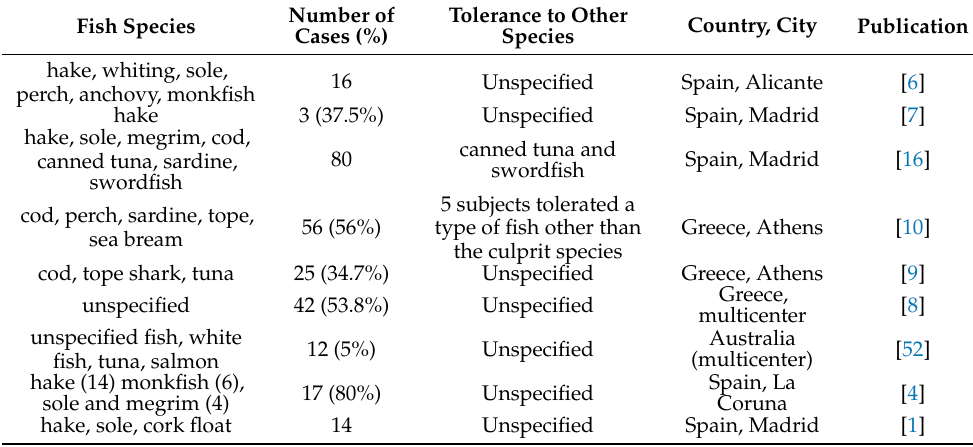
Table 1. Fish species implicated in the presentation of FPIES in